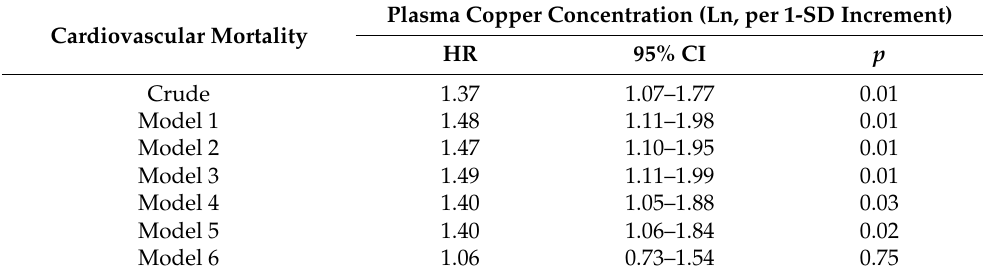
Table 2. Association between plasma copper concentration and cardiovascular mortality in KTR. Plasma Copper Concentration (Ln, per 1-SD Cardiovascular Mortality